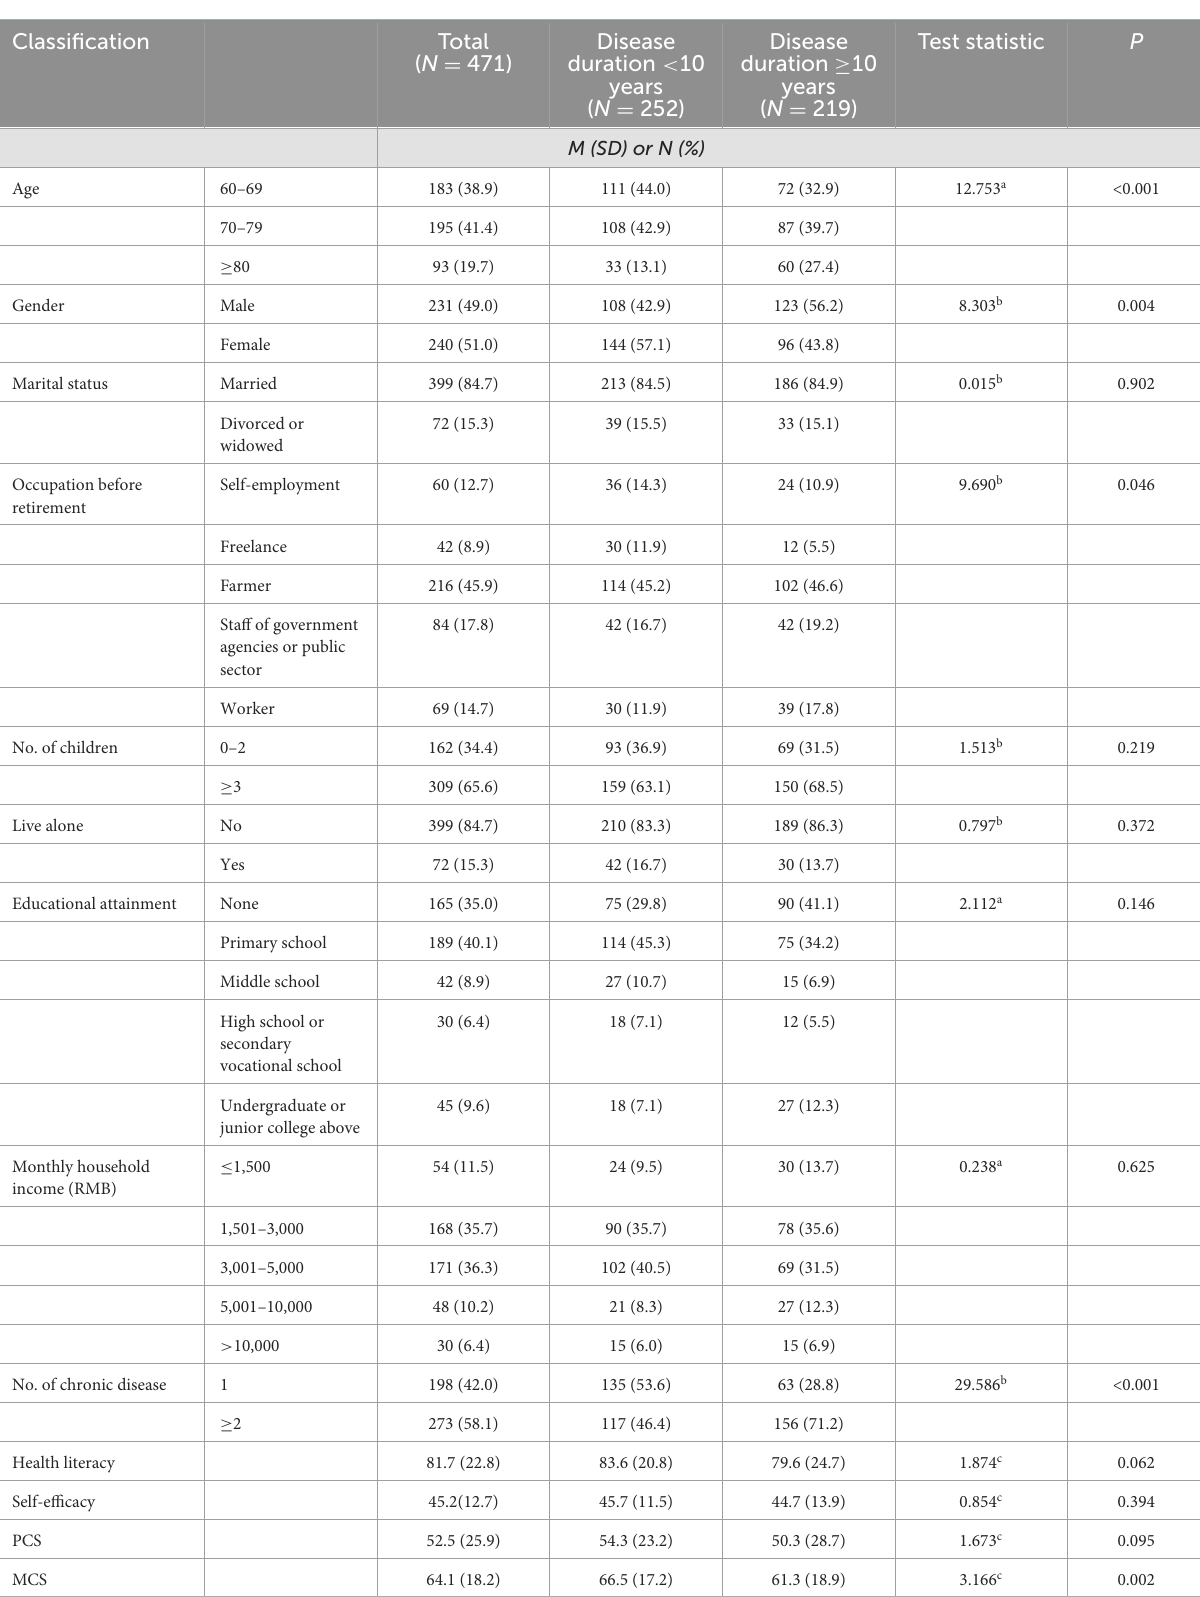
TABLE 1 Descriptive statistic of the participants ( N =